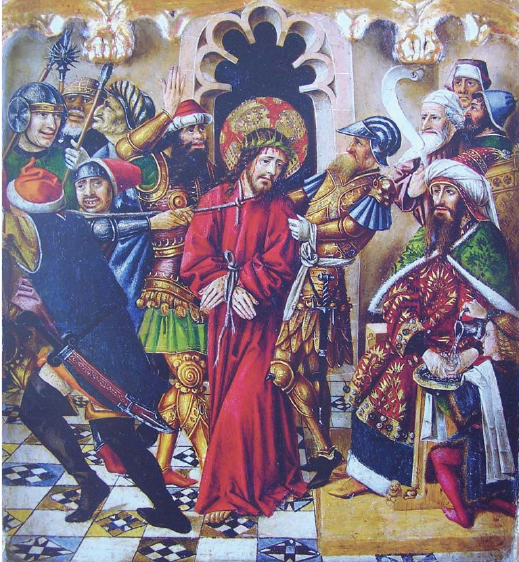
Figure 6. Predella with eight scenes of the Passion of Christ, Joan Reixach, second half of the 15th century, Museu de Belles Arts of Valencia. © Museu de Belles Arts of Valencia. Here, the crown of thorns as well as the blood that flows from the wounds they cause are readily visible. His hands are tied, and a rope pulls from His neck. According to Carlos Espí, His executioners, and Pontius Pilate who washes his hands, dress in Eastern clothing that links them to both Jews and Muslims. The scene, while narrative and part of a larger cycle, keeps the focus of piety on the pain of a Jesus with a sad countenance, whose face is framed in the dark background of the polylobed arch that gives him a certain distance from the rest of the composition (Espí 2014, p. 25).